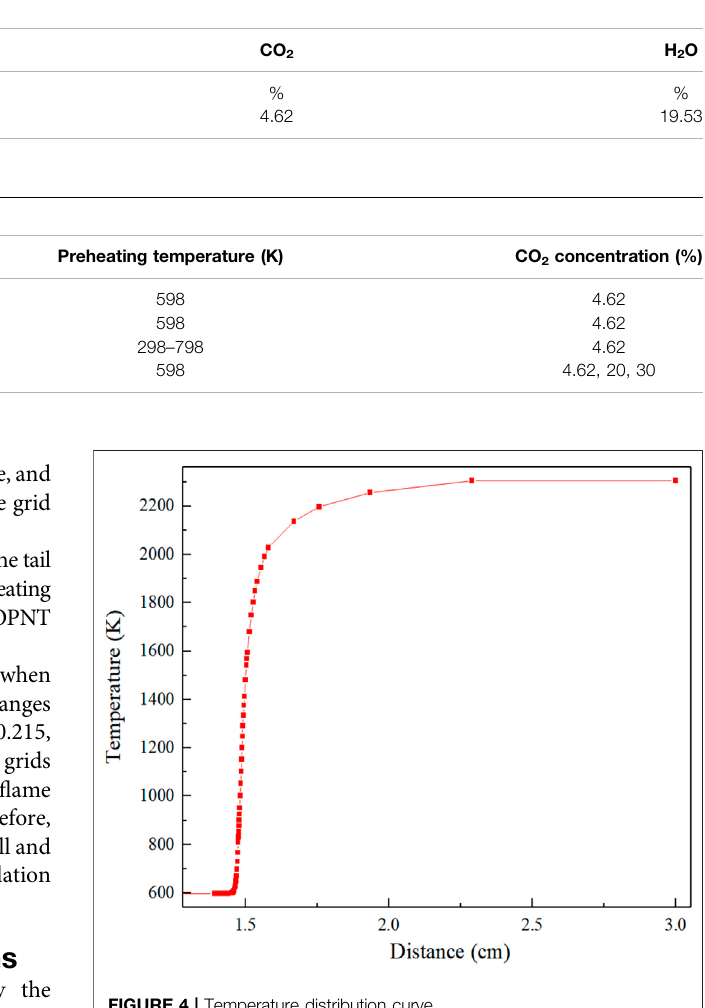
FIGURE 4 | Temperature distribution